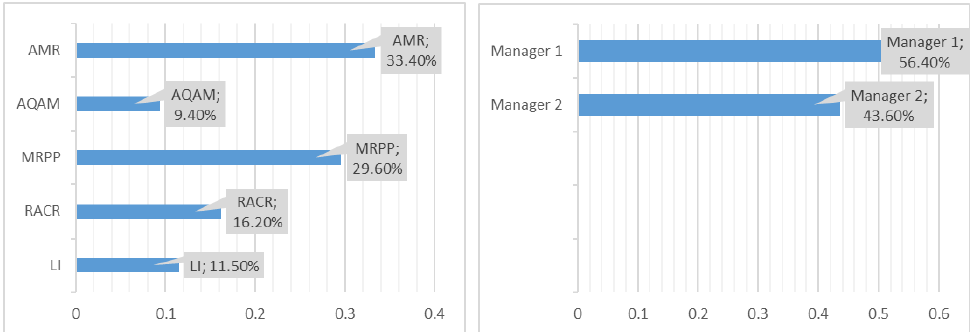
Figure 5. Scenario 3 (own processing).